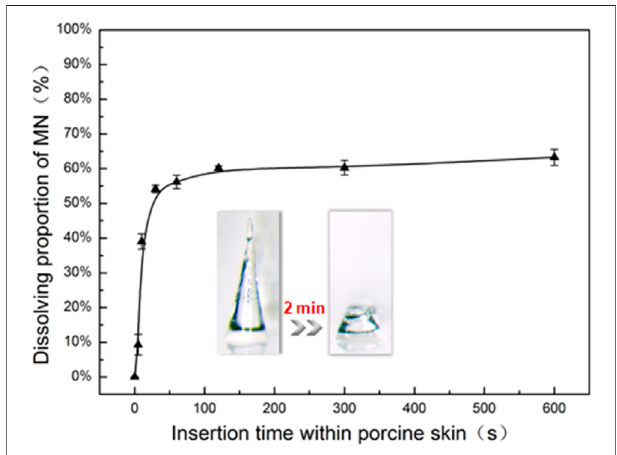
FIGURE 6 | In vitro dissolution pro fi le of FITC-insulin loaded MNs inserting into porcine skin with different times (n (cid:1) 3, mean ± SD).